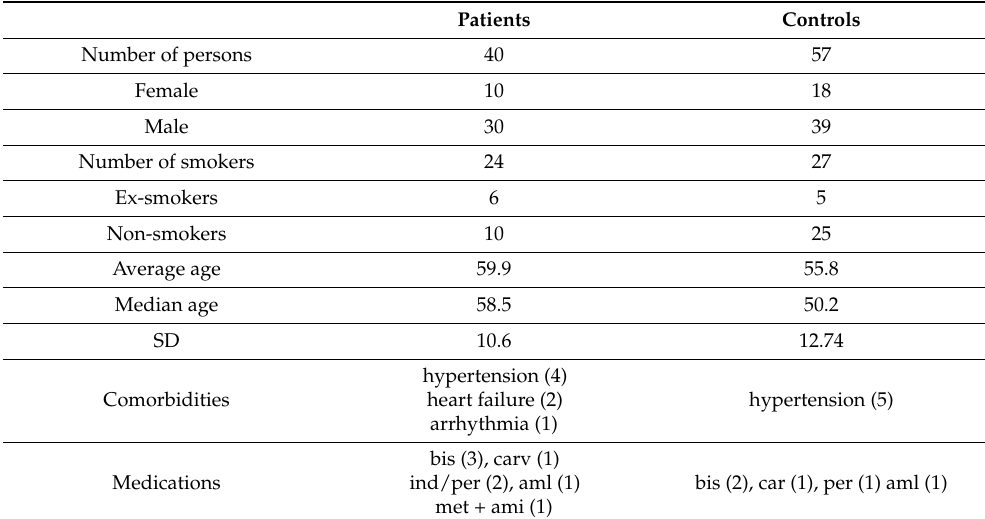
Table 3. Demographic